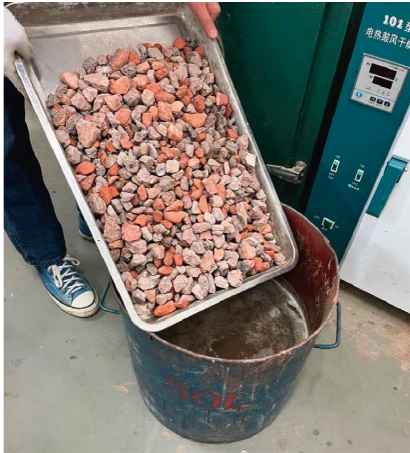
Figure 5: PVA solution soaking recycled aggregate.